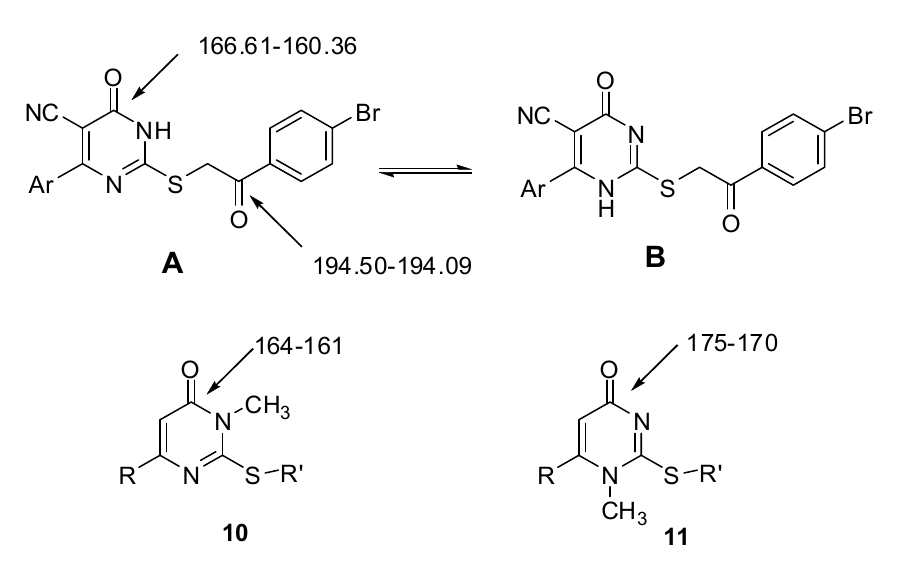
Figure 2. Possible tautomeric structures of compounds 6a – i and 13 C-NMR chemical shifts of reported